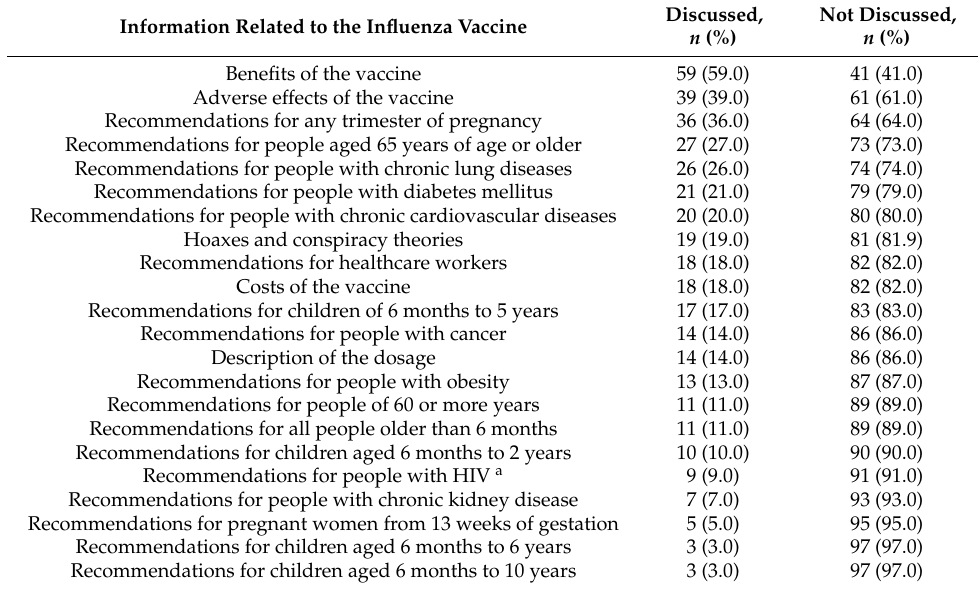
Table 3. Information related to the influenza vaccine discussed in the